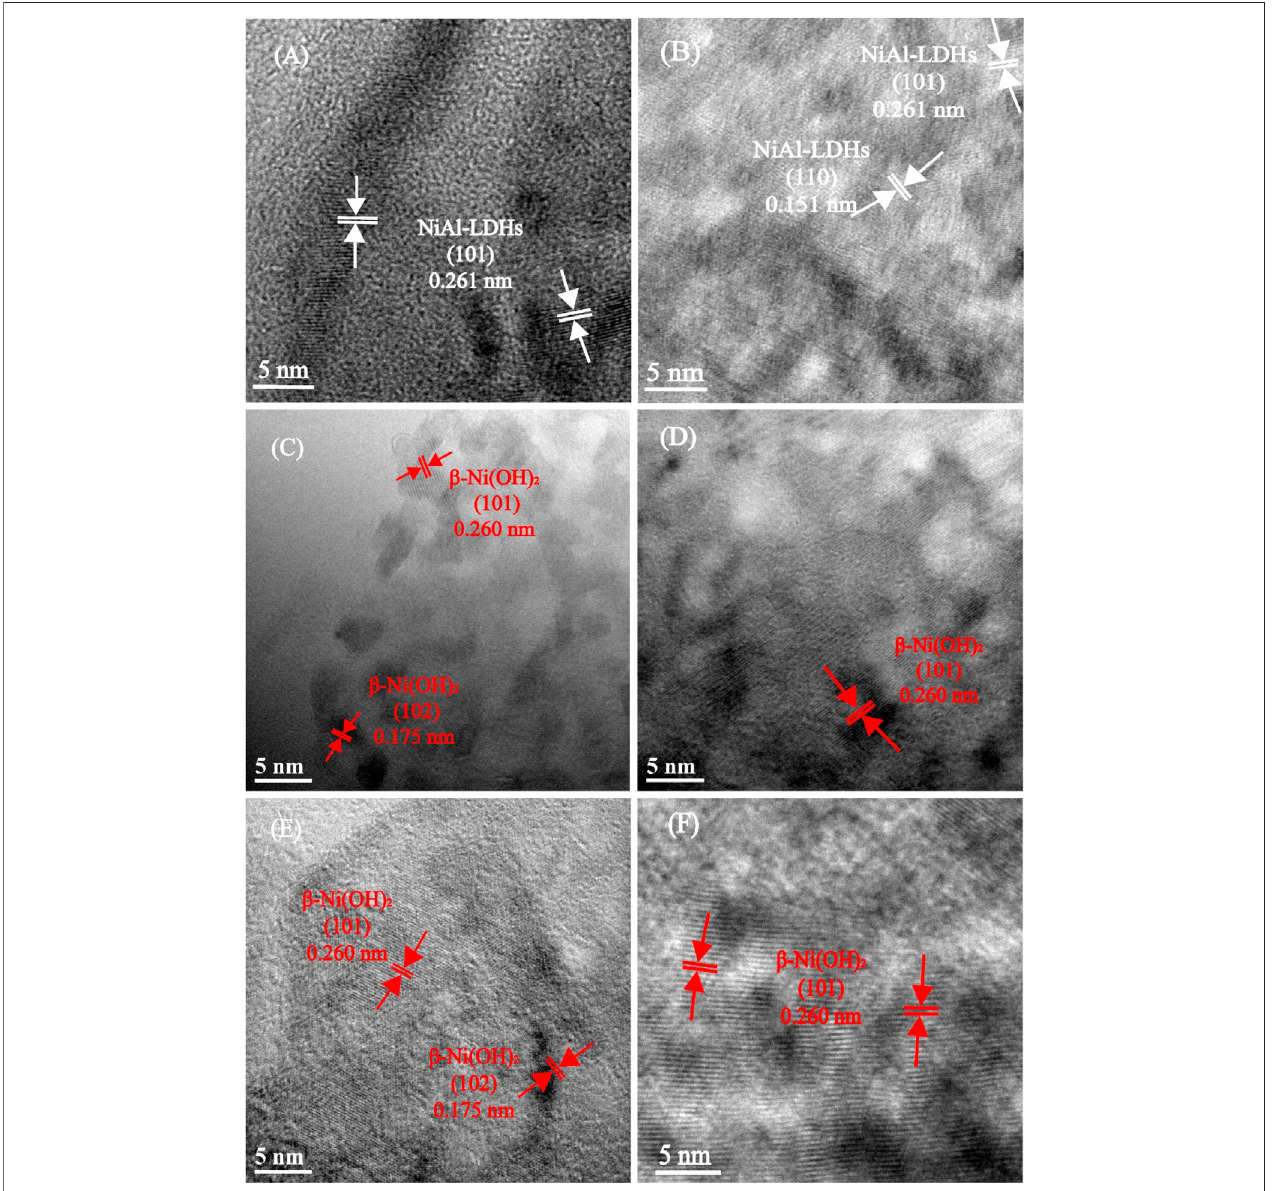
FIGURE4| HRTEMimagesofNiAl-LDHsprecursor (A) ,thealkaline-etchedsamplesin5 (B) ,10 (C,D) ,and15 (E) MKOHsolution,and β -Ni(OH) 2 sampleprepared by precipitation reaction (F) .